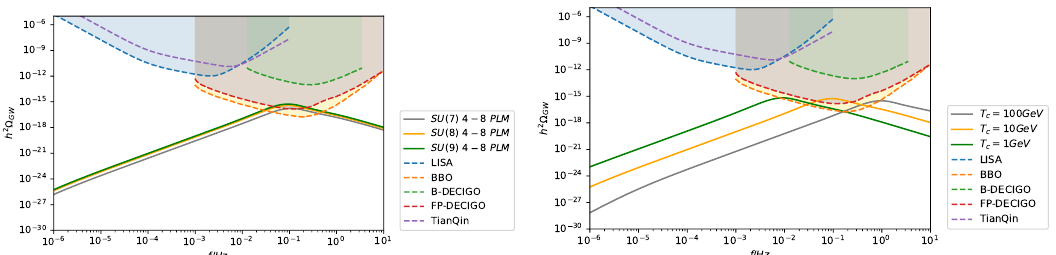
Figure 8 . Left panel: GW signals of 4 − 8 PLM PTs with N = 7 , 8 , 9 at T c = 10 GeV . Right panel: the dependence of the critical temperature T on the GW signals from the N = 9 4-8 PLM. Both c panels have taken into account the SM contribution ( ζ = 1